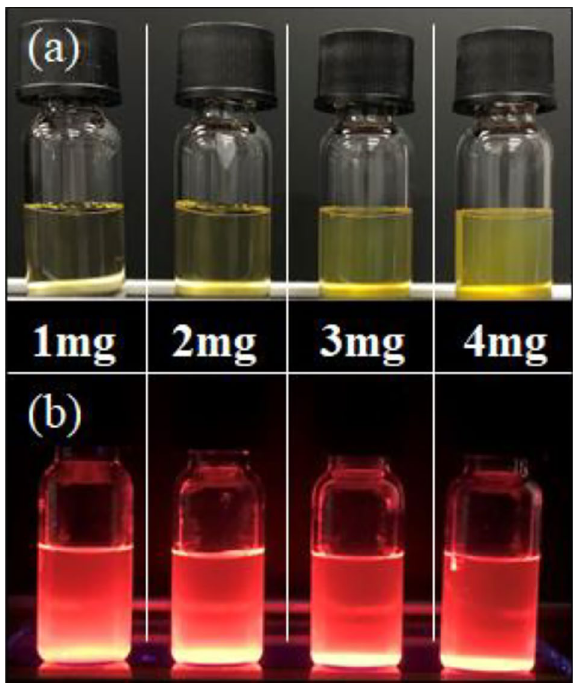
Figure 4. Digital photographs of milli-Q water containing 10-undecanoic-acid-terminated SiQDs at different concentrations under room light irradiation (upper line) and 365 nm UV light irradiation (lower line), respectively.